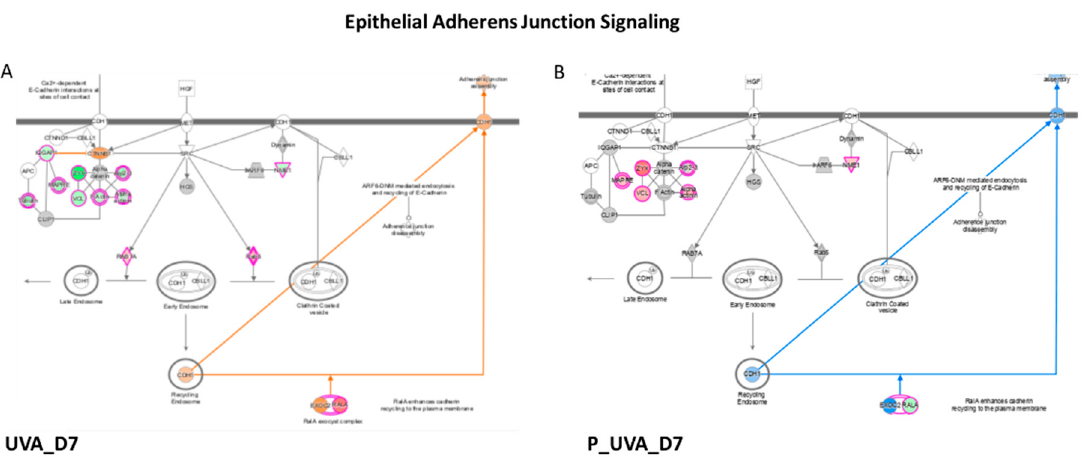
Figure 3. Epithelial Adherens Junction Signaling enhanced in UVA vs. control in ( A ) and decreased in ( B ) P_UVA vs. UVA (IPA). Red shows the increased features covered by our input database and green shows those decreased features. The orange color of the central hub indicates an upregulation of the module. For the node shapes: Knowledge: IPA Legend (salesforce-sites.com) (Qiagen, USA). Table 2. Proteins involved in the Epithelial Adherens Junction Signaling. Log2 ratio ≥ 0.6 indicates upregulation, log2 ratio ≤ − 0.6 represents downregulation.